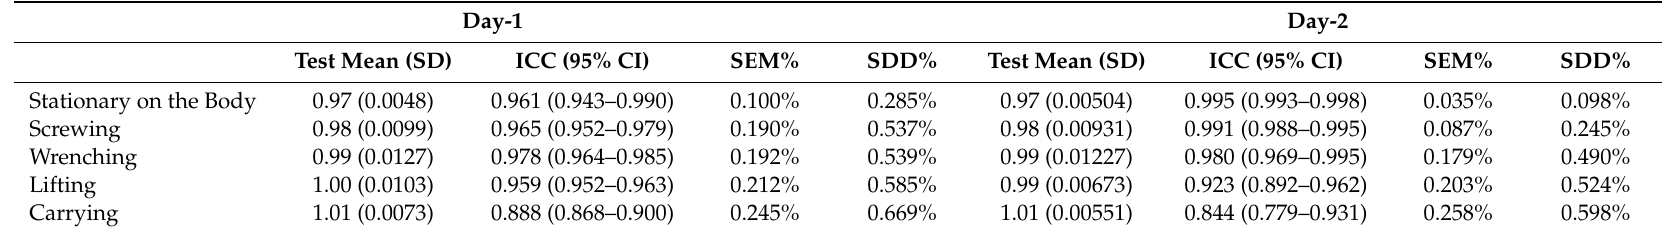
Table 5. Accelerometer trial-to-trial reliability.